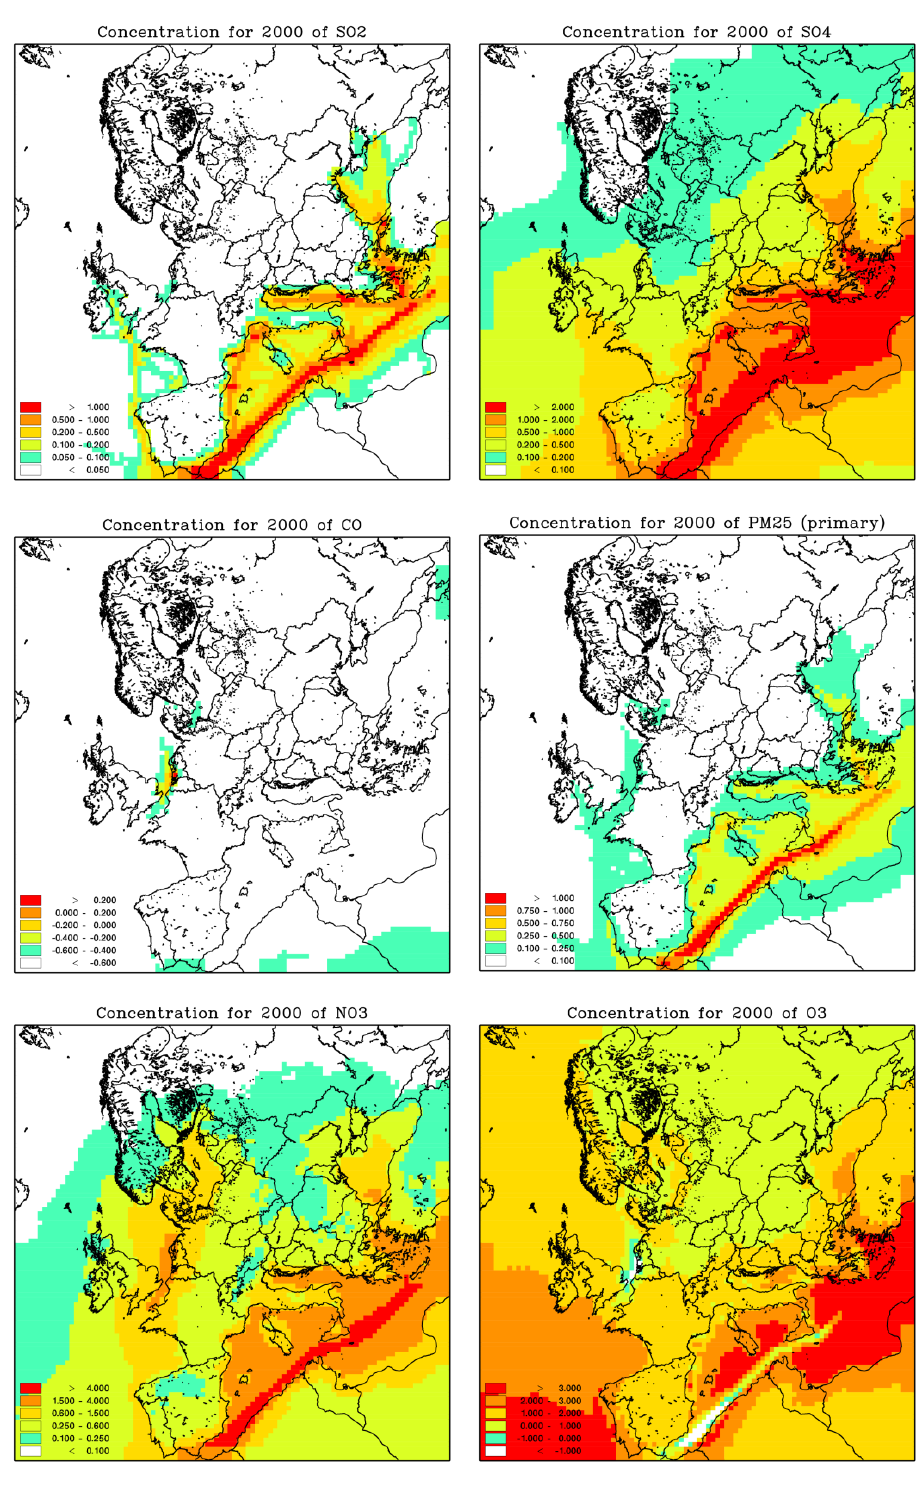
Fig. 6. As Fig. 5, but for the year